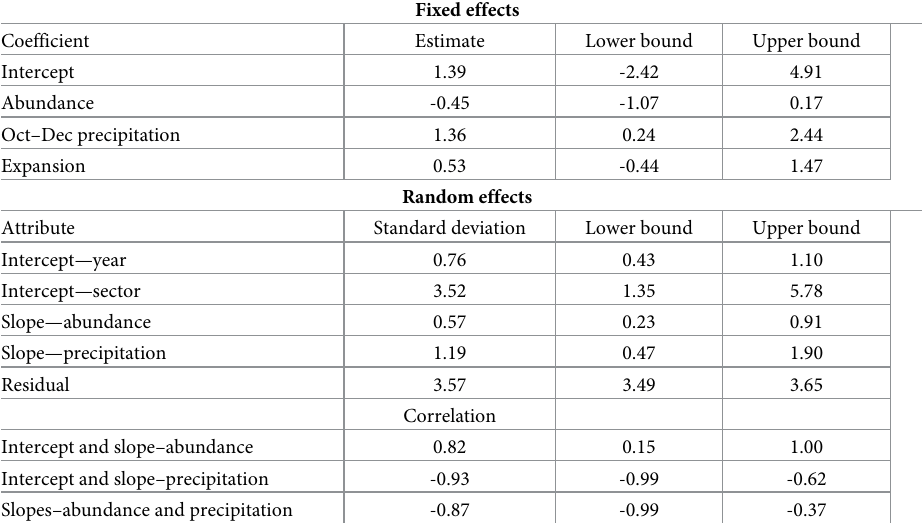
Table 2. Estimates and 95% confidence bounds of the fixed and random effects of a linear mixed-effects model summarizing forage biomass. Abundance was scaled to have a mean of zero and standard deviation of one and Oct– Dec Precipitation was natural logarithmic transformed. Reference category for expansion is years before (2006–2016) the Davison herd expanded into the fish hatchery and cattle pasture sectors. Year had only intercept random effects whereas abundance and precipitation had intercept and slope random